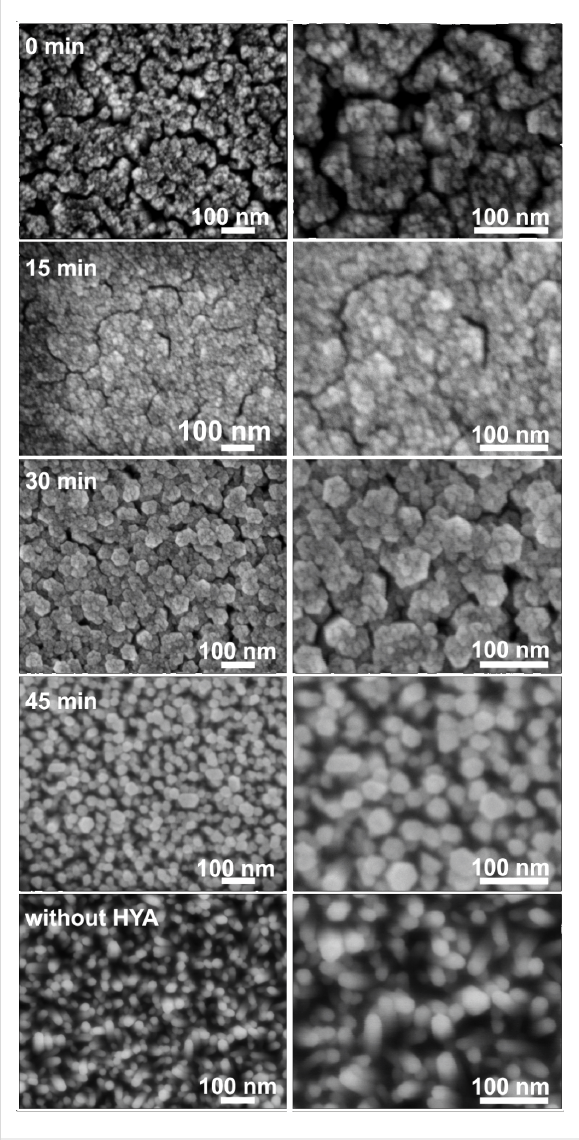
Figure 4: SEM micrographs of ZnO films after the first CBD. Growth was performed for 1 h in total with and without the addition of HYA. HYA was supplied after specific time intervals during the growth process as